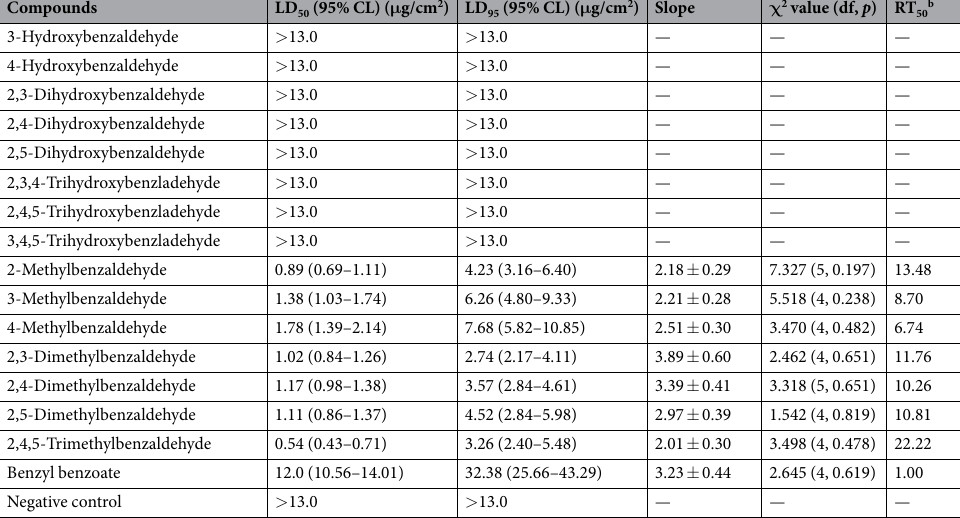
Table 5. Acaricidal toxicity of hydroxybenzaldehyde analogues, methylbenzaldehyde analogues and synthetic acaricide against T . putrescentiae , using a contact bioassay ( a LD 50 /LD 95 is the average of 5